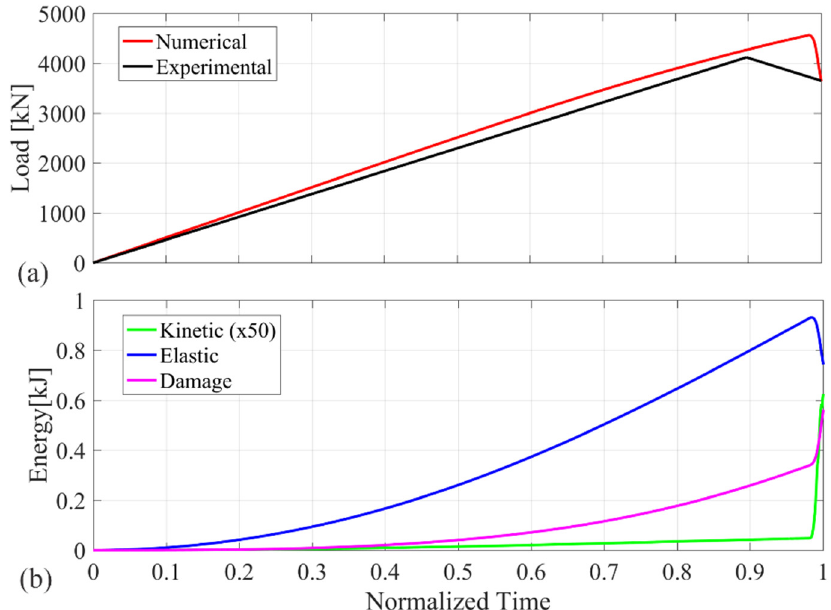
Figure 12. ( a ) Comparison between experimental and numerical results in terms of load versus normalized time. ( b ) Energy balance presented during the simulation.